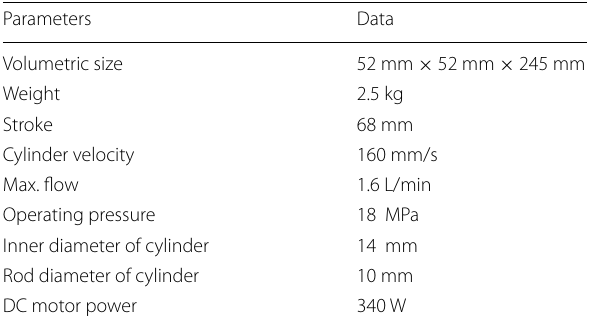
Table 1 Specifications of the hip